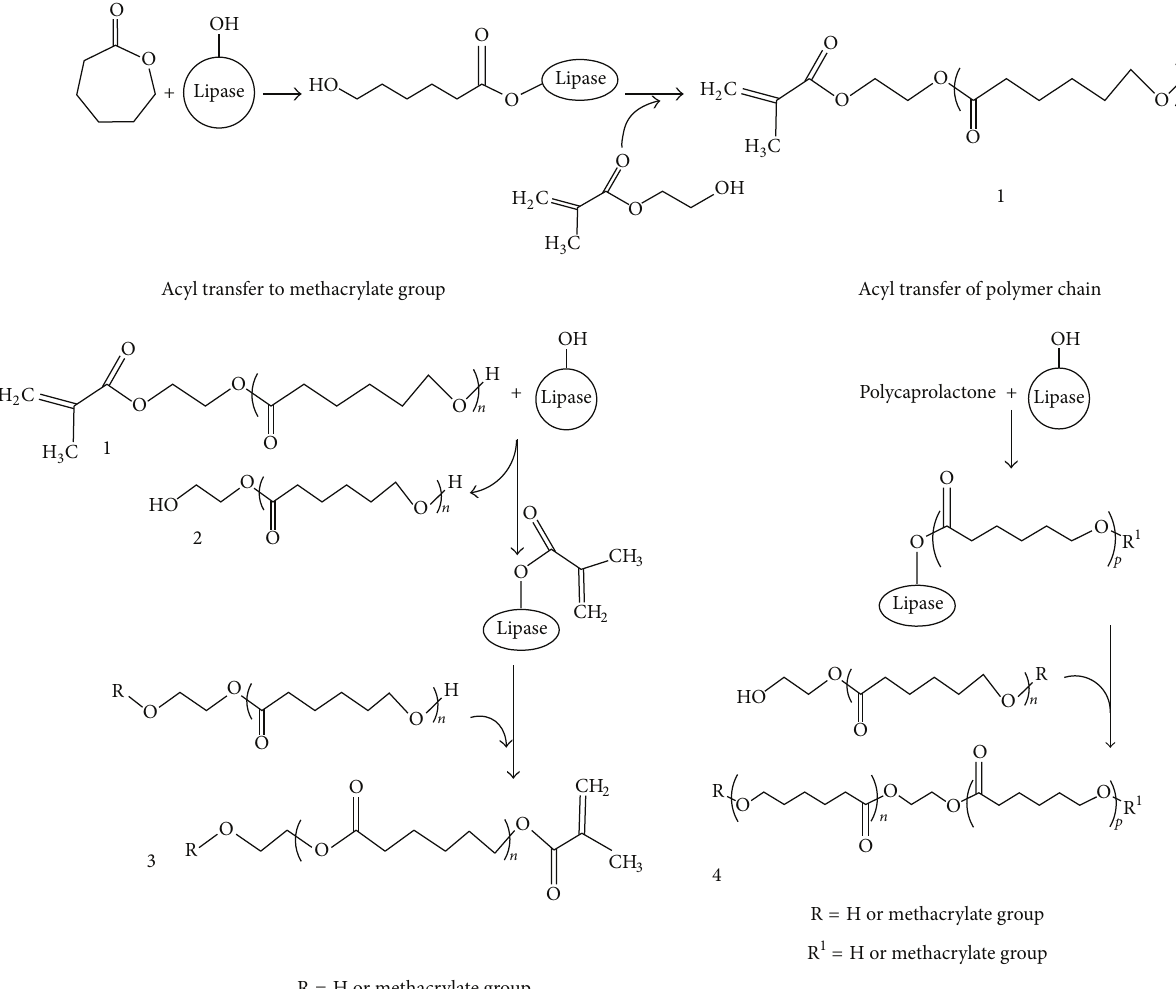
Figure2:eROPofCLandsidereactionsthereof:methacrylatetransfer(HEMAend-groupofthepolymertohydroxylend-groupofpolymer); 1,2-ethanediol formation inside the polyester chain [12,